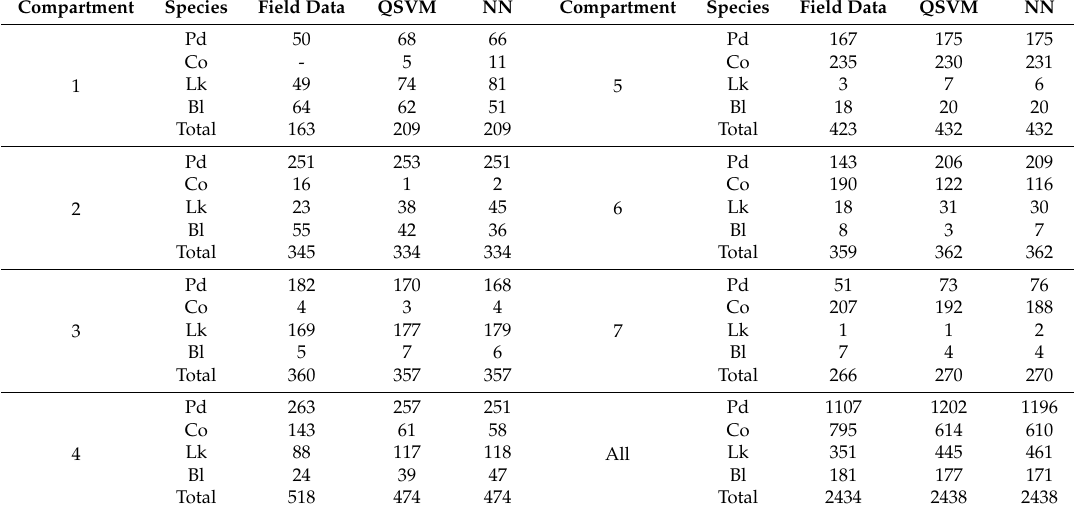
Figure 10. Tree crown classification based on the quadratic SVM ( a ) and neural network ( b ) models. Pd, Pinus densiflora ; Co, Chamaecyparis obtusa ; Lk, Larix kaempferi ; Bl, broadleaved trees. Table 6. Count of the upper trees surveyed in the field data and classified using different approaches based on distinguishing species. QSVM, quadratic SVM classifier; NN, neural network; Pd, Pinus densiflora ; Co, Chamaecyparis obtusa ; Lk, Larix kaempferi ; Bl, broadleaved trees. Compartment